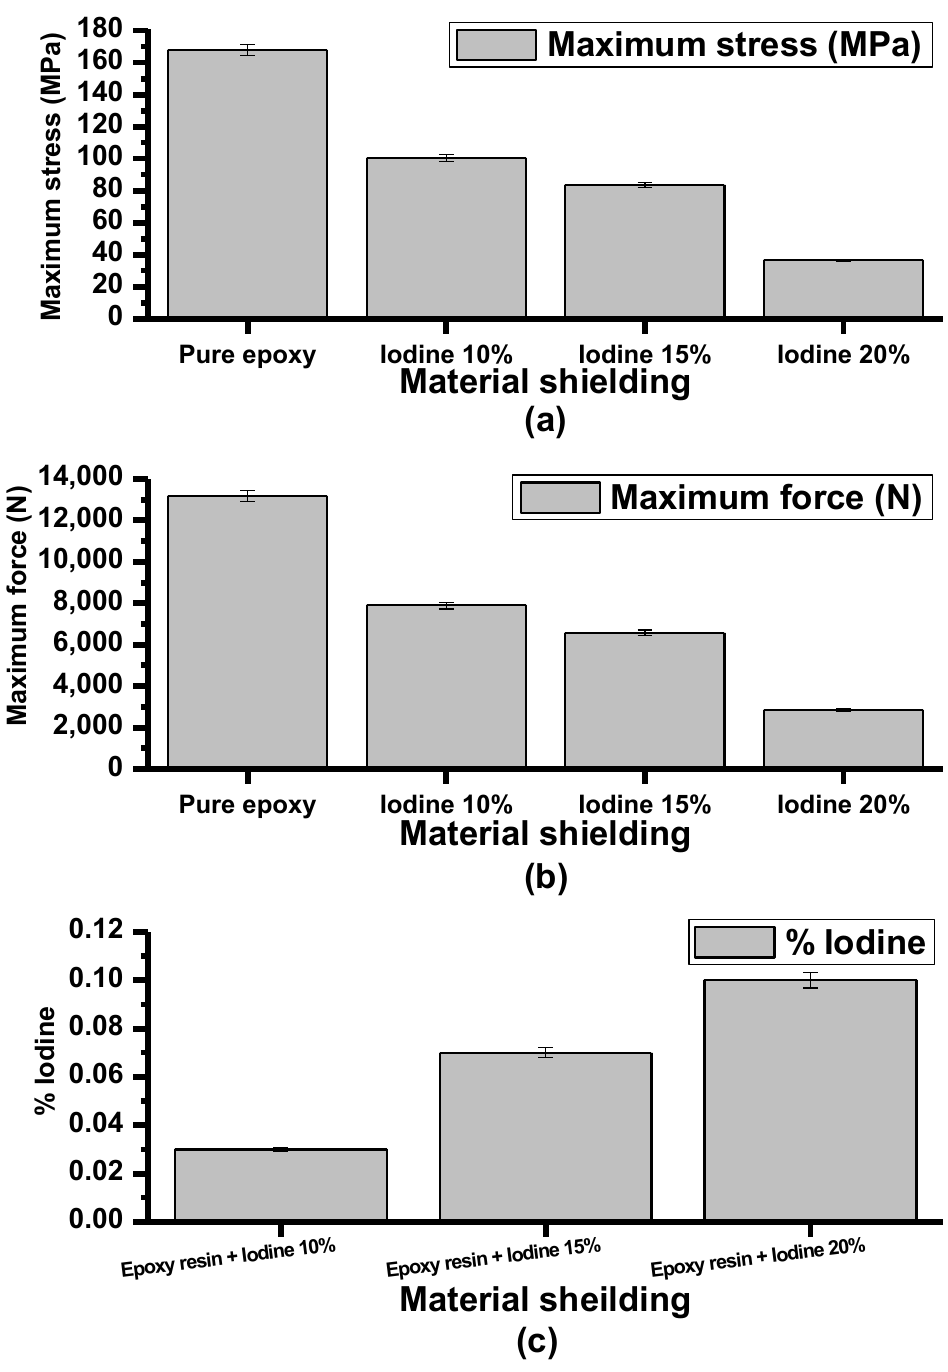
Figure 7. Comparison of ( a ) maximum stress (MPa), ( b ) maximum force (N), and ( c ) X-ray fluores- cence.